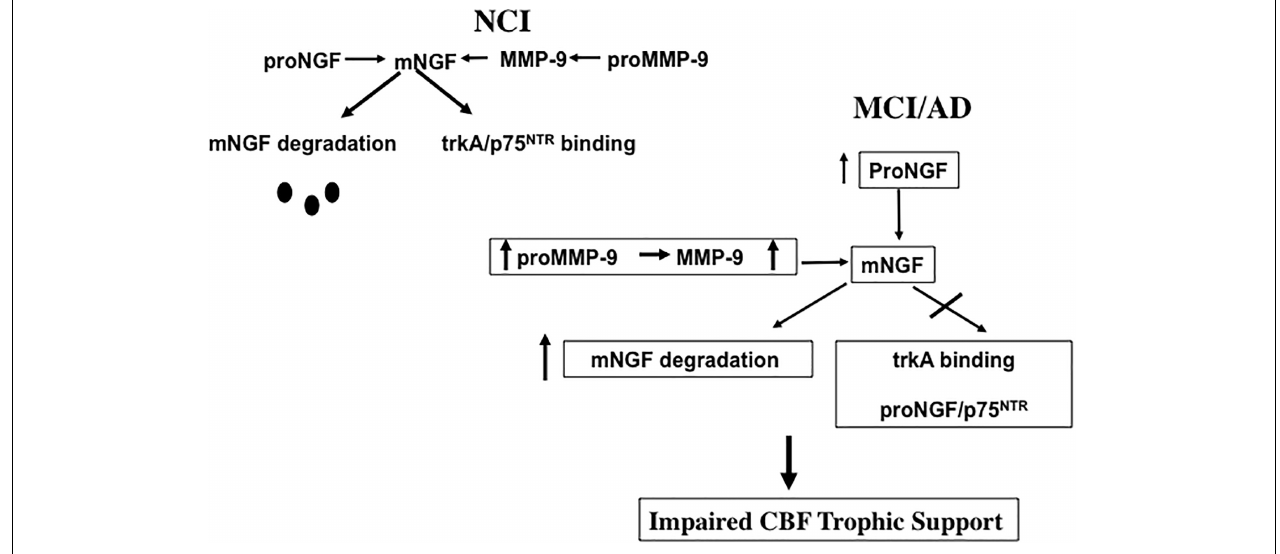
FIGURE 7 | Diagram illustrating the effect of an increase of proMMP-9/MMP-9 has upon the ability of NGF to support cholinotrophic basal forebrain neurons during the progression of AD.